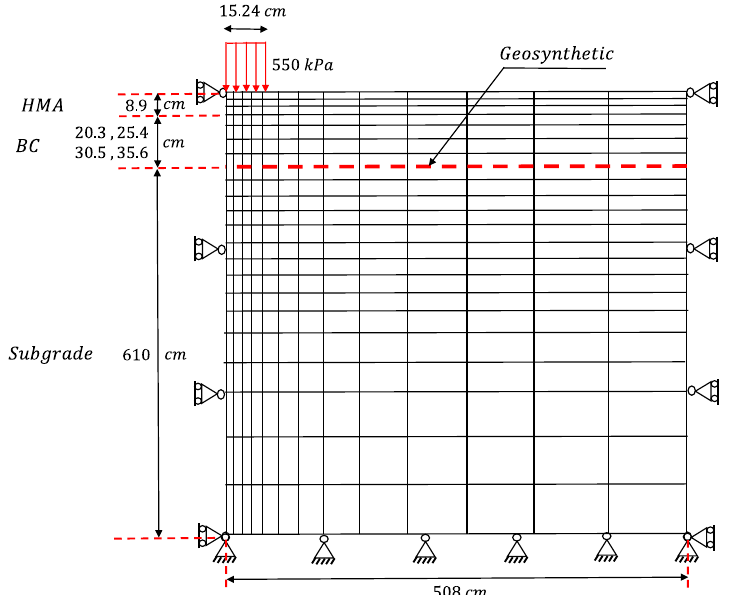
Figure 1. Schematic view of geosynthetics reinforcement at the base/subgrade interface and dimen- sions of the FE models.